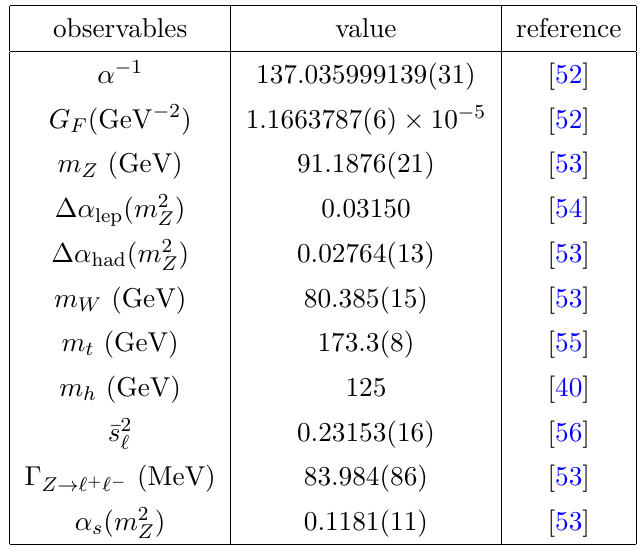
Table 2 . Values of observable use to constraint the STU parameters.